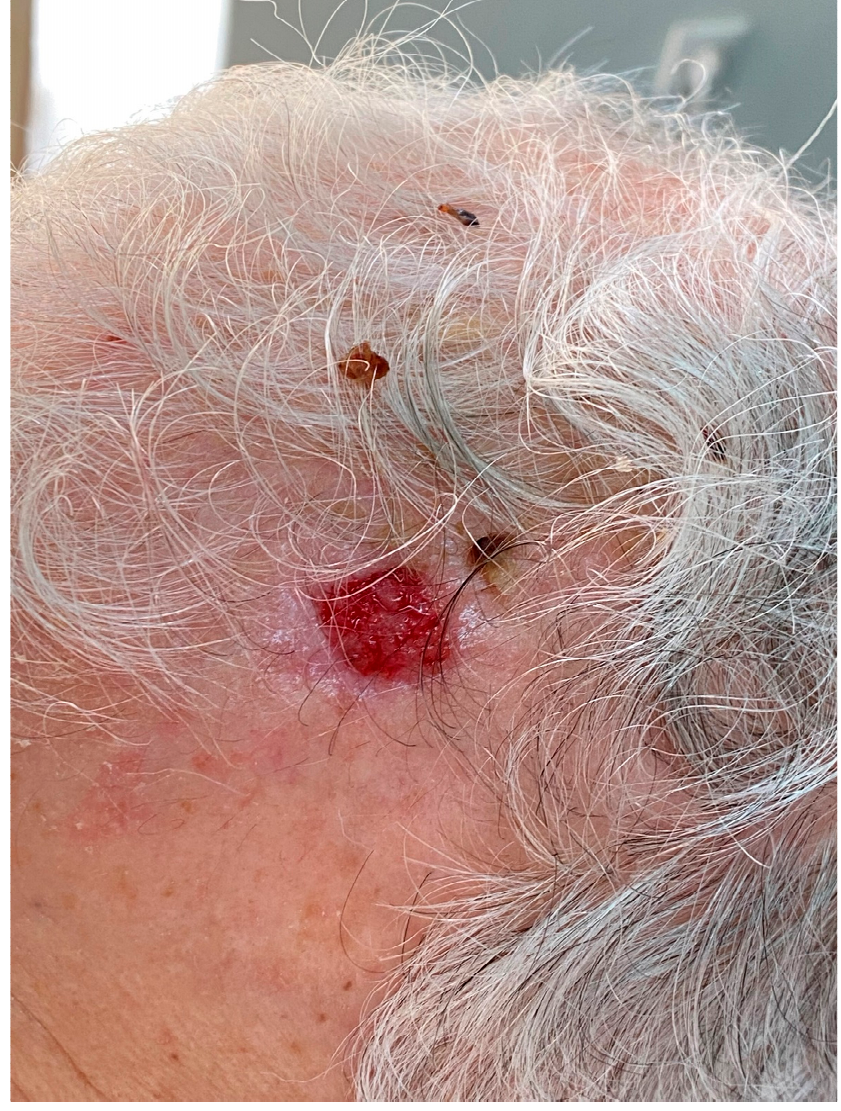
Figure 1. Clinical presentation of eccrine porocarcinoma in a 75-year-old patient, showing an ulcer- ated lesion of 15 mm in diameter on the left temporal area.